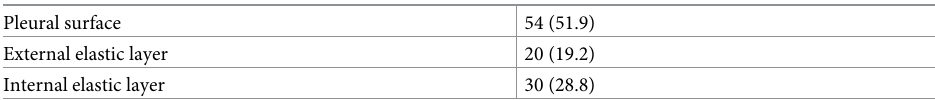
Table 2. Invasion depth of 104 visceral pleural endometriotic lesions, n